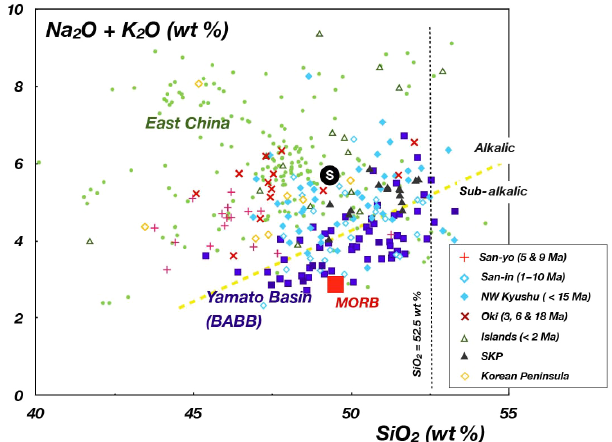
Figure 3. Whole rock SiO 2 and total alkali (Na 2 O + K 2 O) con- tents of the basalt from the Seifu Seamount (black circle anno- tated with S). The alkali and sub-alkali boundary lines are from Miyashiro (1978). Basalts from the circum-Sea of Japan area are shown for comparison. BABB: back-arc basin basalt from the Yam- ato and Japan basins. Data sources: Dostal et al. (1988), Naka- mura et al. (1989, 1990), Allan and Gorton (1992), Iwamori (1992), Miyake (1994), Uto et al. (1994, 2004), Basu et al. (1991), Chung (1999), Kim et al. (1999), Pouclet et al. (1995), Zou et al. (2000), Zhang et al. (2002), Choi et al. (2006), Yan and Zhao (2008), Lee et al. (2011), and Hirahara et al. (2015).